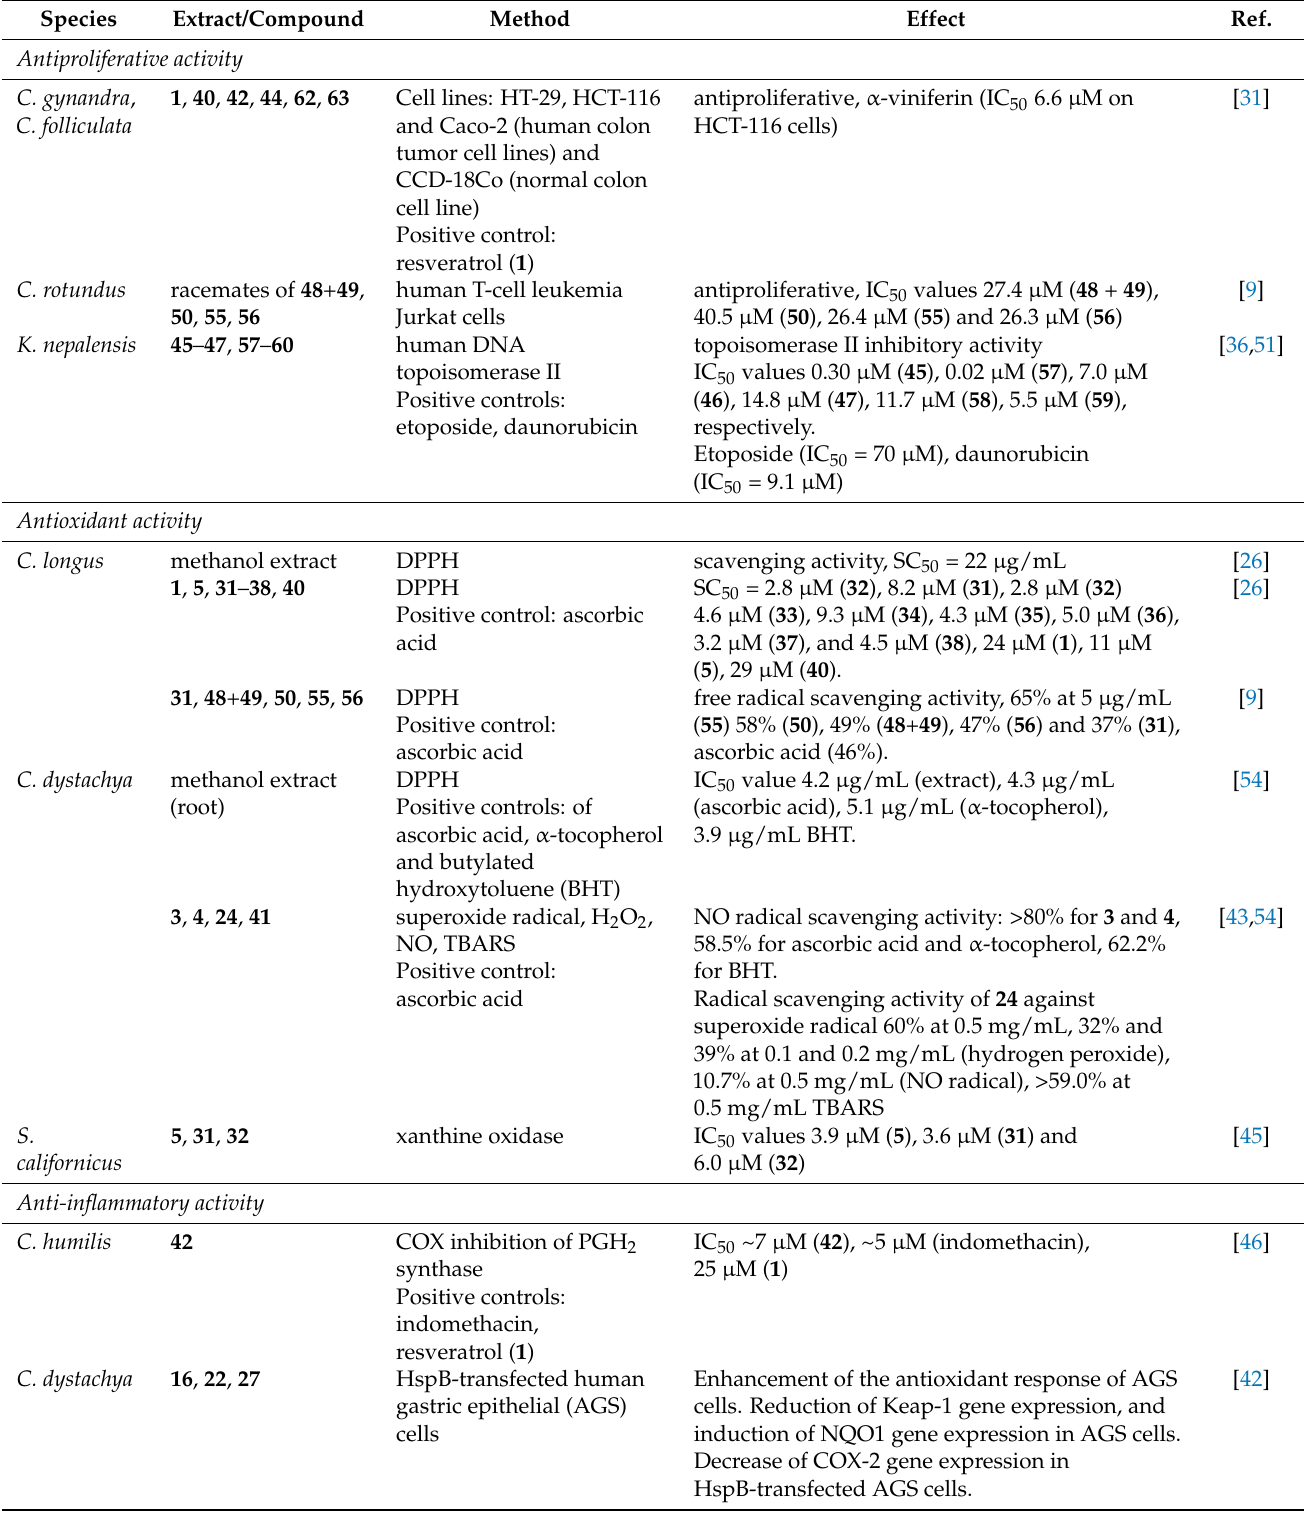
Table 2. Pharmacological activities of Cyperaceae extracts and isolated stilbenes.